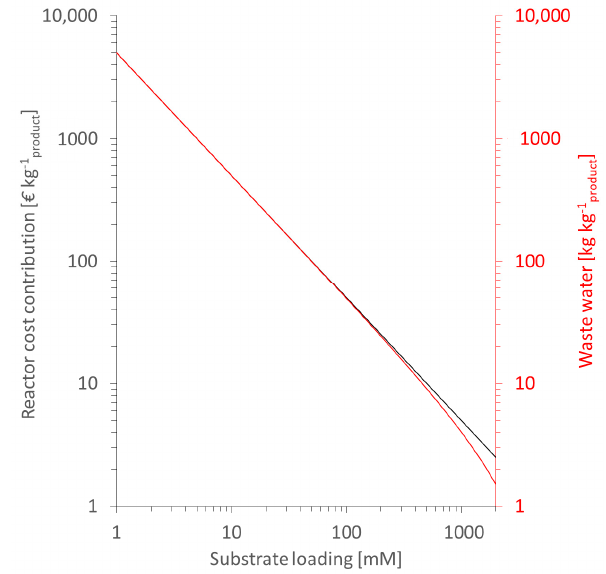
Figure 2. Estimation of the cost contribution of a reactor cost contribution ( black ) and waste water formed ( red , based on a simple E-factor calculation). Assumptions: full conversion of the starting material into the product (Mw = 200 g mol − 1 ) and generic reactor costs of 1 € L − 1 reaction volume.